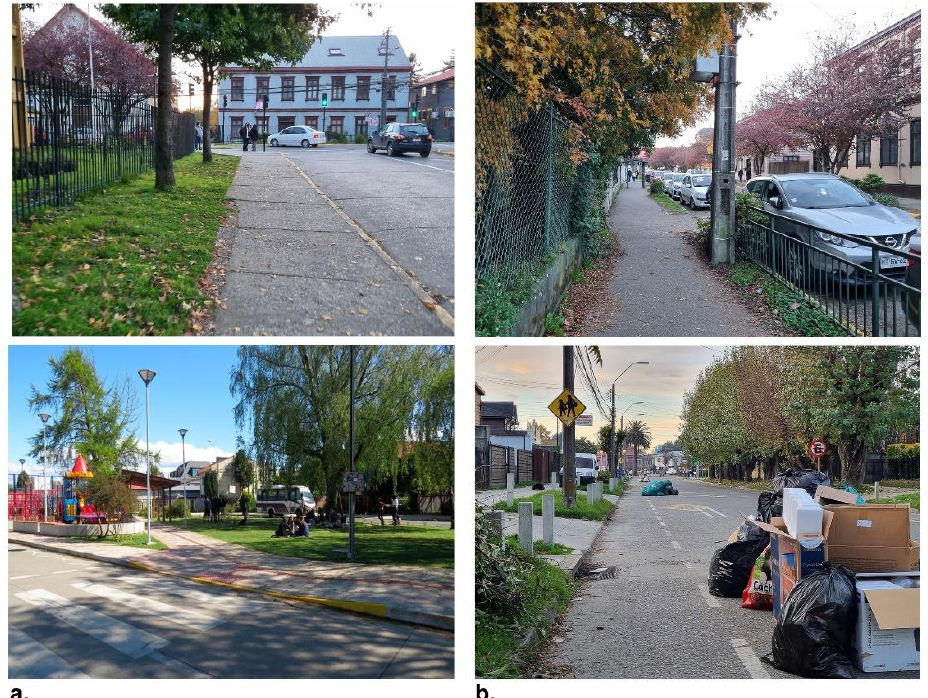
Figure 9. ( a ) Trees on streets, wide sidewalks and architectural heritage on street frontages are the most preferred elements that promote walking based on the perceptions of walkers; ( b ) parked cars on sidewalks, narrow sidewalks and garbage on inner streets are elements that inhibit walking, based on the perceptions of walkers. Pictures were taken during interviews with participants, according to the elements that interviewers highlighted while walking. Source: Authors.